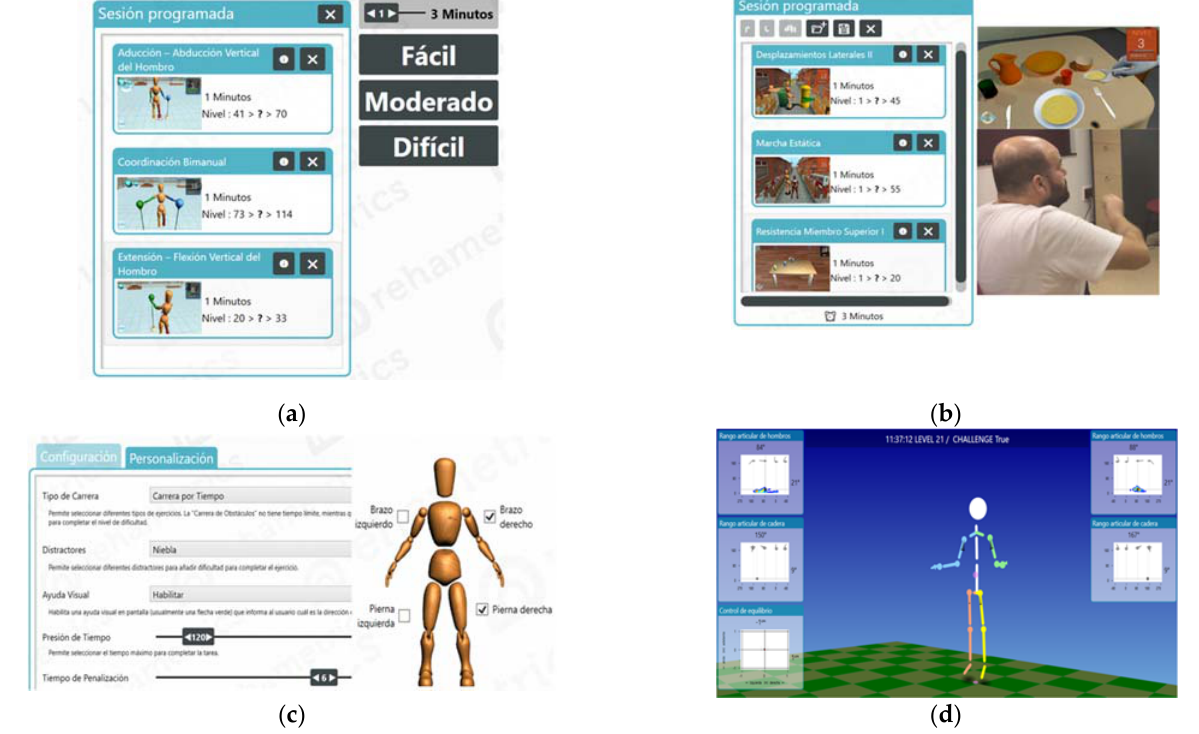
Figure 1. ( a ) Selection of analytical exergames; ( b ) selection of functional exergames; ( c ) adaptation of exergames at the beginning of a treatment session; ( d ) graphical representation of results or progress of the